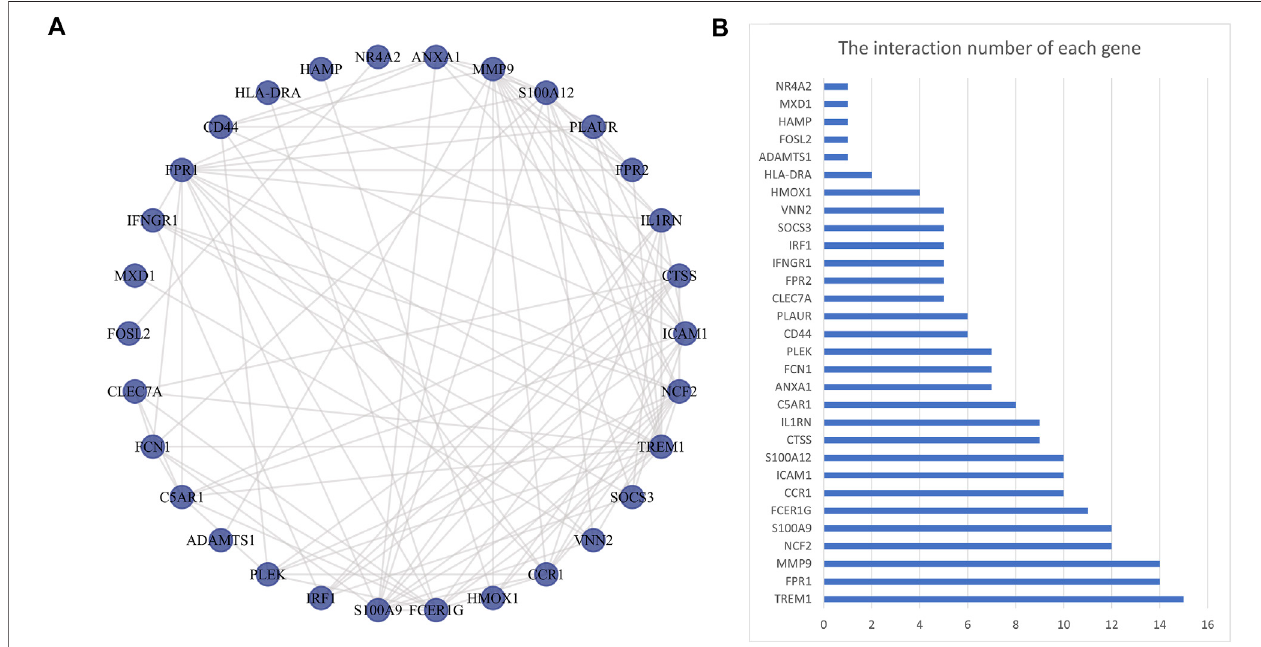
FIGURE 4 | Protein-protein interaction network. Panel (A) , The PPI among overlapping DEGs. Panel (B) , The interaction number of each DEG. Abbreviations: DEGs, differentially expressed genes; PPI, protein-protein interaction.